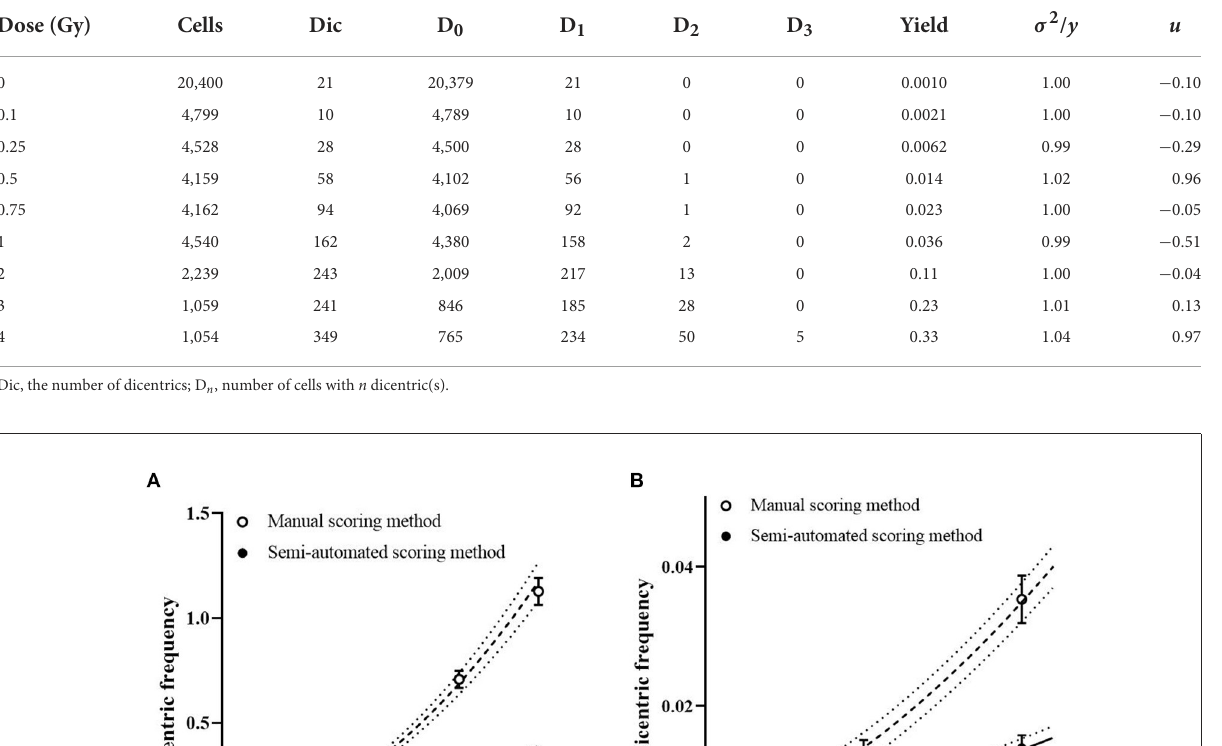
were categorized into binary categories using a threshold dose of 0.1Gy, which can distinguish never vs. ever radiation exposure